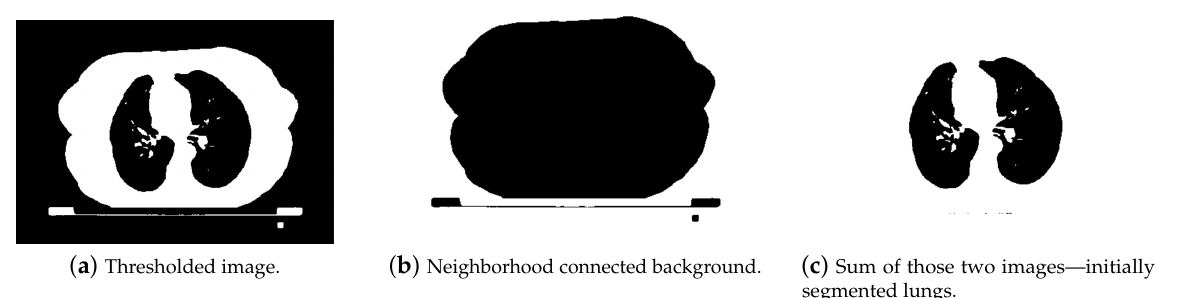
Figure 13. Example of the segmentation steps using the SimpleITK